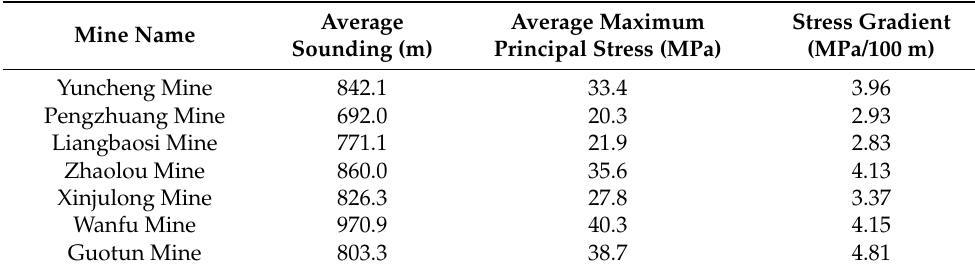
Table 5. Stress gradient values of each mine.